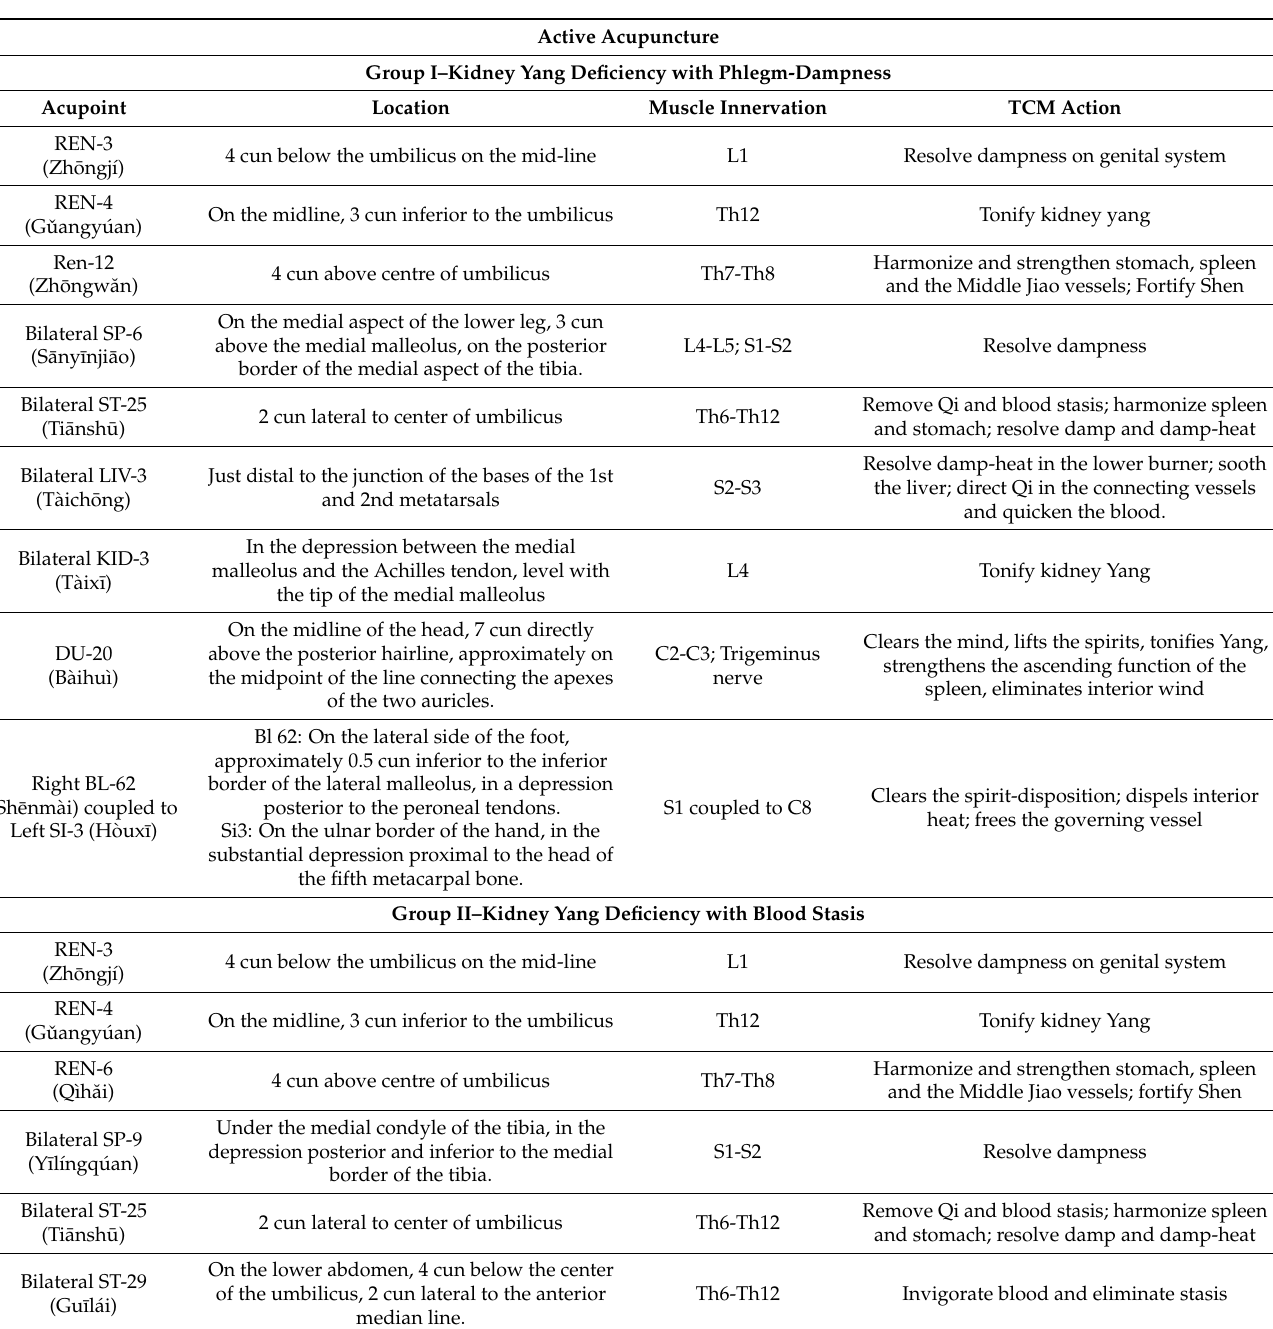
Table A1. Description of the active and sham acupuncture protocol proposal for women with PCOS based on a recent literature